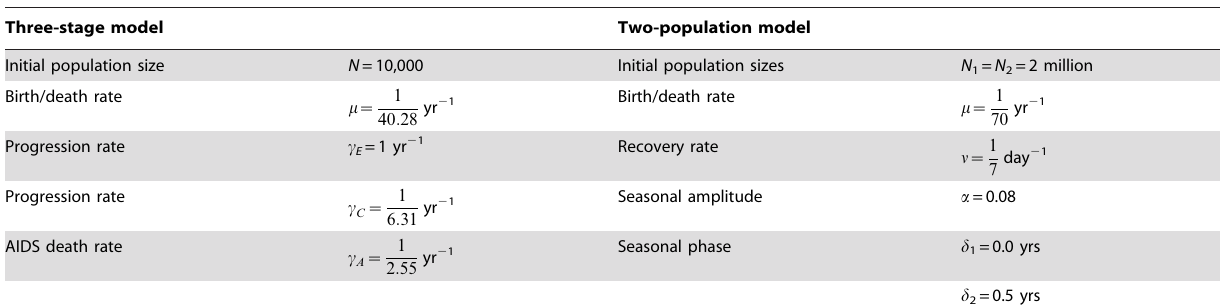
Table 1. Fixed parameters in the epidemiological